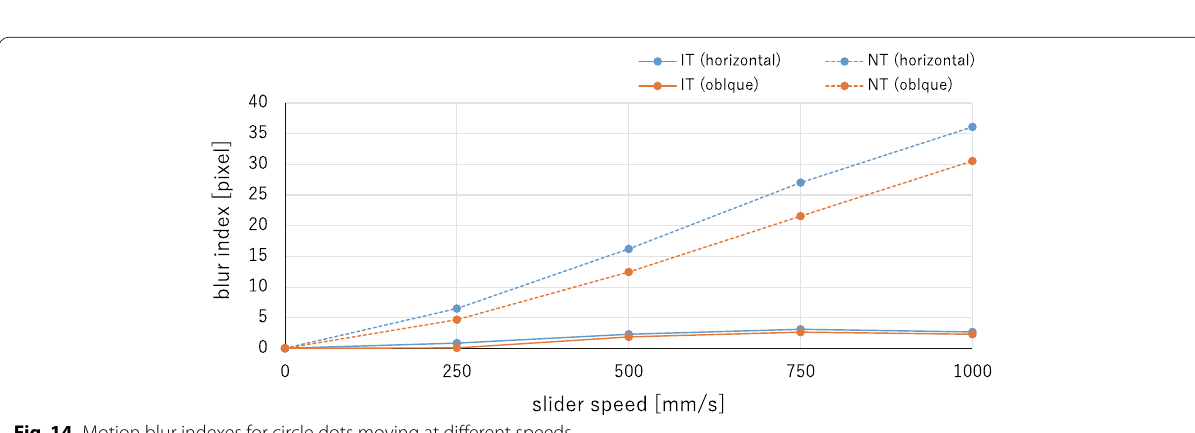
speeds of 3, 4, 5, 6, and 7 m/s. In the experiment, a CCTV 0.391 mm corresponded to one pixel. When observing an × = 75 lens of f object moving fast on a plane of 4350 mm in front of the mm was used with a 1.5 extender; the 200 × 200 mirror-drive 2-DOF active vision system, the maximum mm area on a plane at a distance of 4350 mm 512 × 512 motion-blur-free speeds were 5.21 m/s in the horizontal corresponded to an image region of pixels and